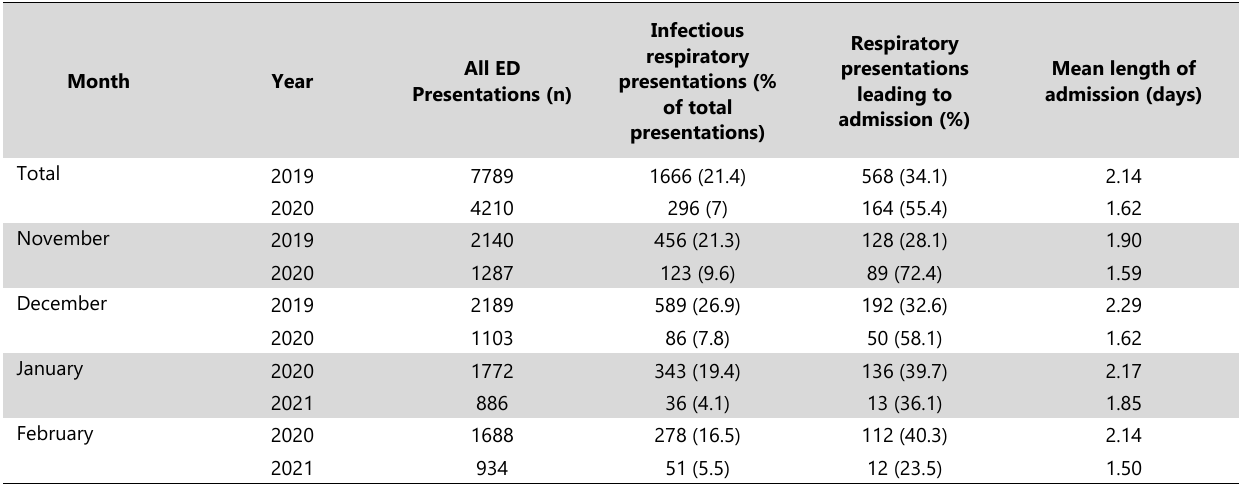
Table 1. Respiratory Presentations to the Emergency Department (ED) Pre-COVID-19 and During-COVID-19.